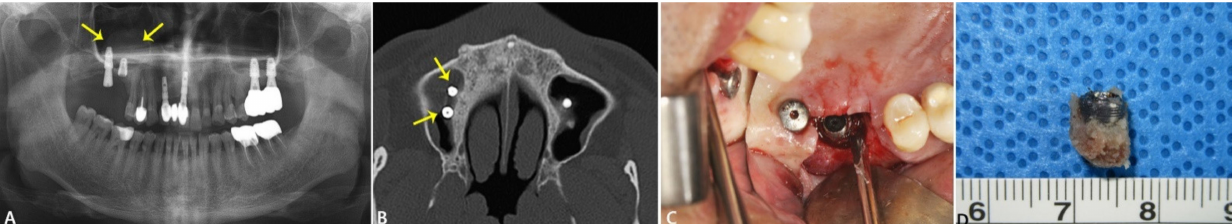
Figure 1. Preoperative radiographic examination of case 1. The panoramic radiograph shows generalized alveolar bone loss and calculi deposition; furcation involvement of the #36, #37, #46, and #47 teeth; and a round retention pseudocyst surrounding the #16i and #17i implants (marked with arrows) ( A ). Upon CT examination, the #16i implant fixture had a missing abutment and, together with the #17i implant in the right maxillary sinus (marked with arrows), mucosal thickening and retention pseudocyst were observed in the right maxillary sinus in the axial view ( B ). Intraoperative view of #16i implant removal ( C ). The #16i implant was removed using forceps and trephine burr ( D